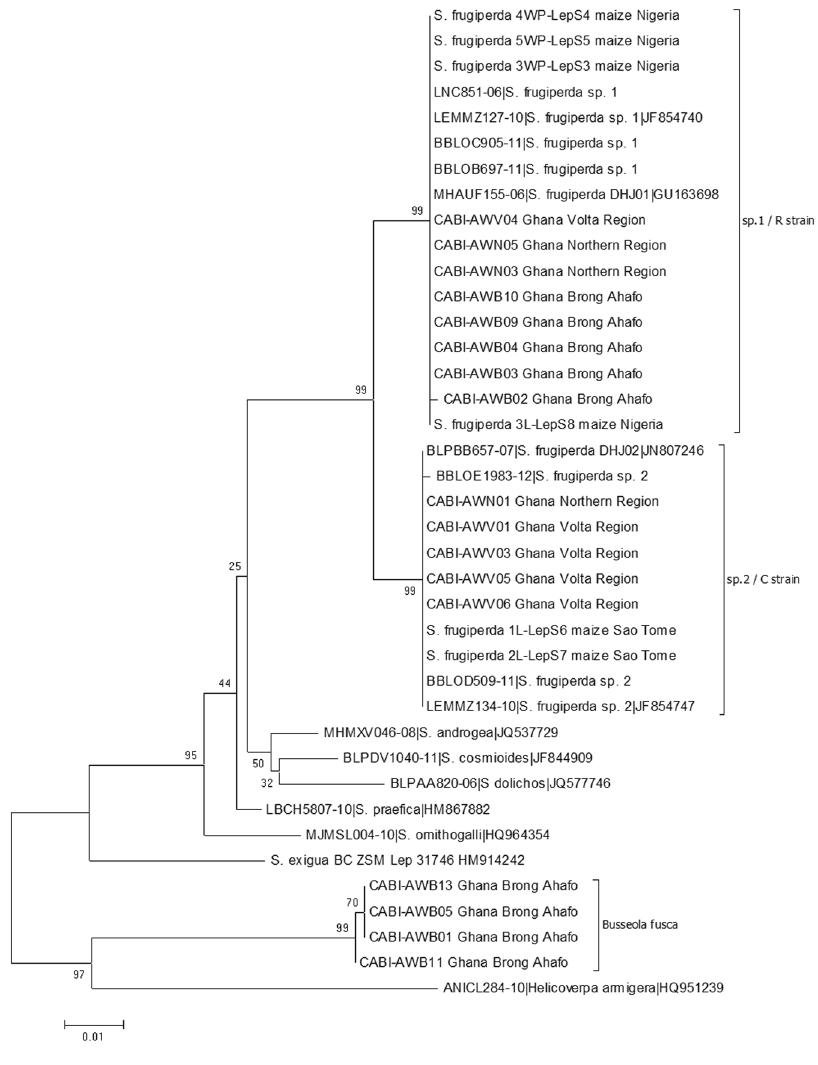
Figure 3. Phylogeny of African Spodoptera frugiperda . This tree includes all available barcodes of African samples and selected American samples to show the relationship between the two species of S . frugiperda and other Spodoptera spp. based on Supplementary Figure 2. Our samples are coded